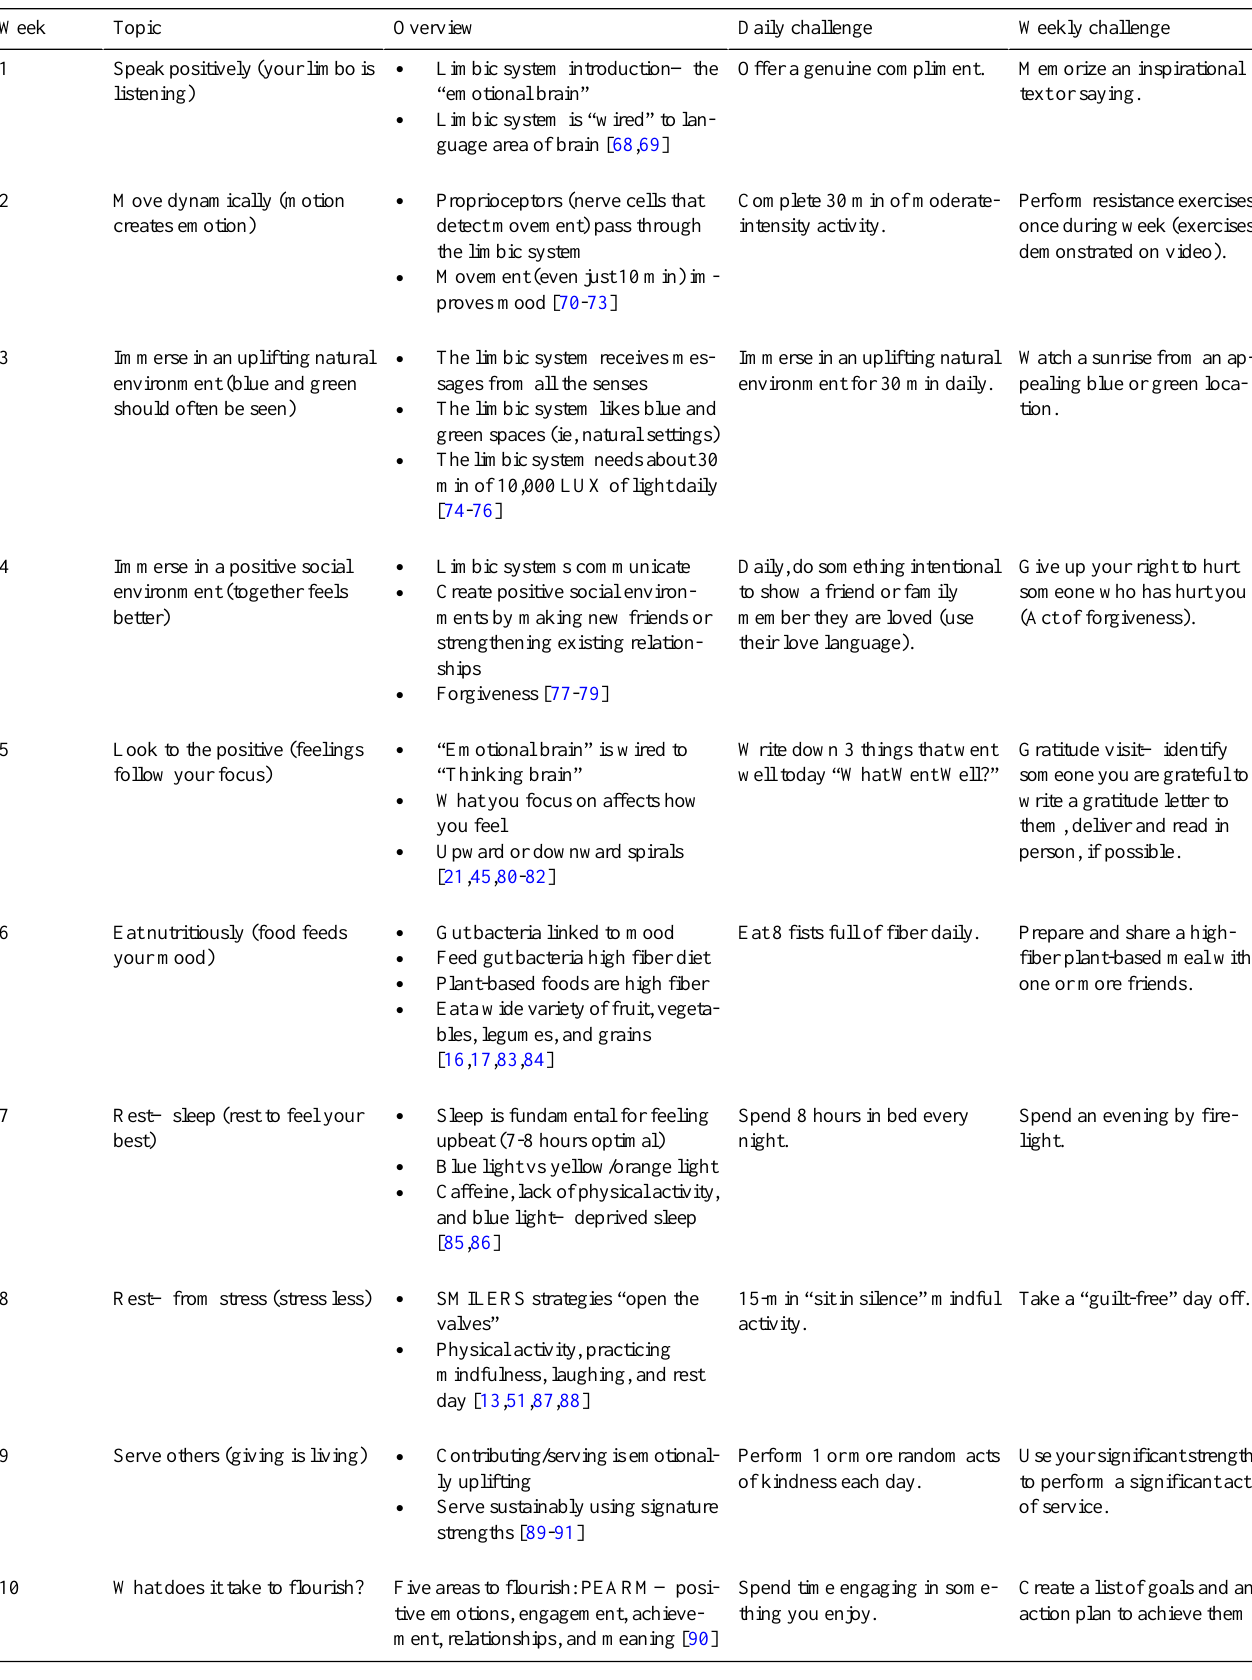
Table 1. Intervention overview.